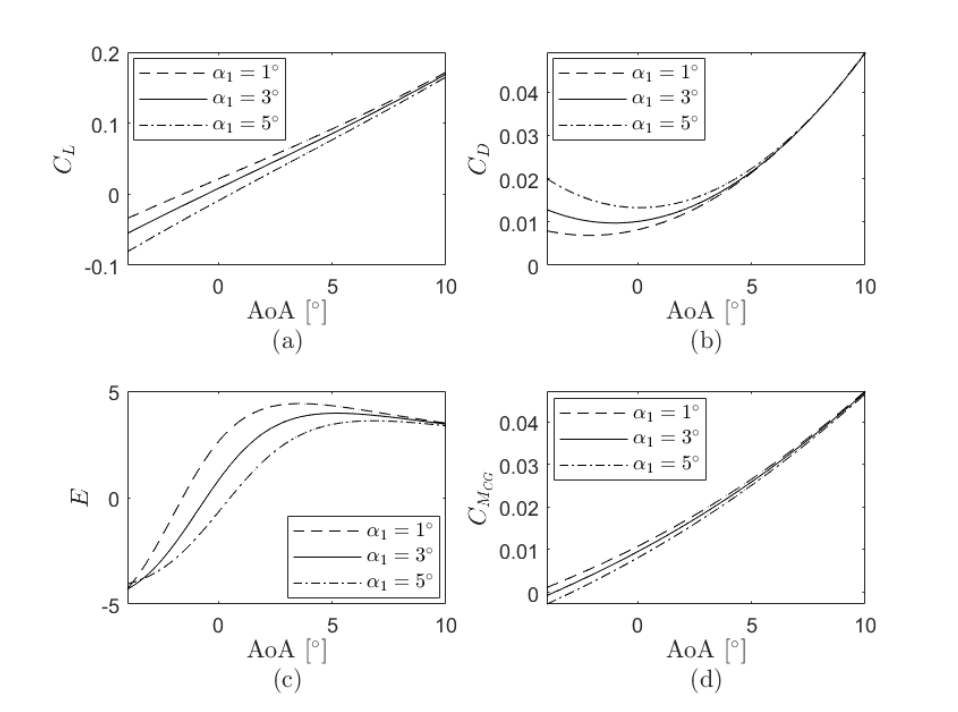
Figure 6. Variations of the aerodynamic parameters due to the modifications in α 1 , ( a ) C L vs. AoA ,